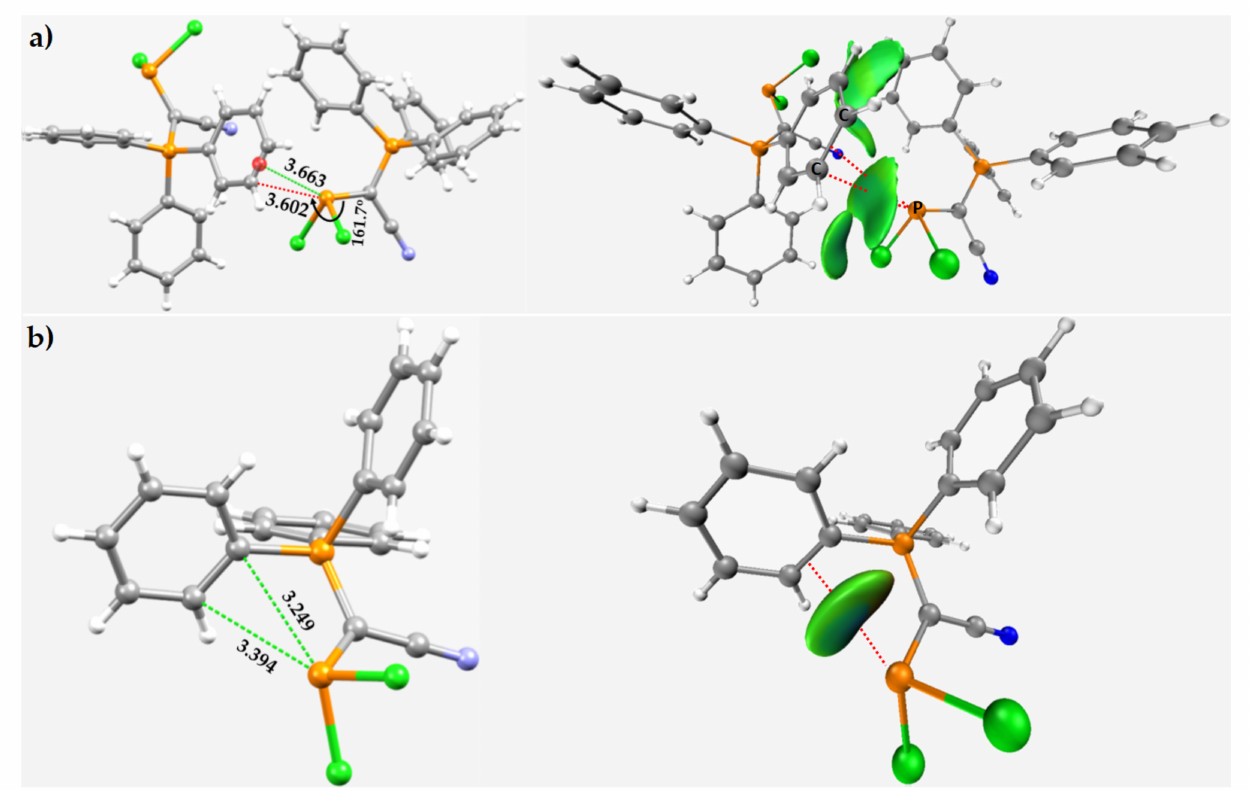
Figure 15. The P ··· π (C=C) pnictogen bonding within the frameworks of the ( a ) dimer and ( b ) the monomer in the crystal structure of cyano(dichlorophosphanyl)(triphenyl-phosphaniumyl)- methanide, Ph 3 P ⊕ C (cid:9) (PCl 2 )(CN) (CSD ref. NABRAN) [119]. The IGM- δ g -based isosurface plots (isovalue = 0.005 a.u.) are shown in each case, displaying the possibility of intermolecular and intermolecular P ··· π (C=C) pnictogen bonds in ( a ) and ( b ), respectively. Selected bond distances and bond angles are shown in Å and degrees, respectively. The dotted line between atoms in green represents the inter/intramolecular